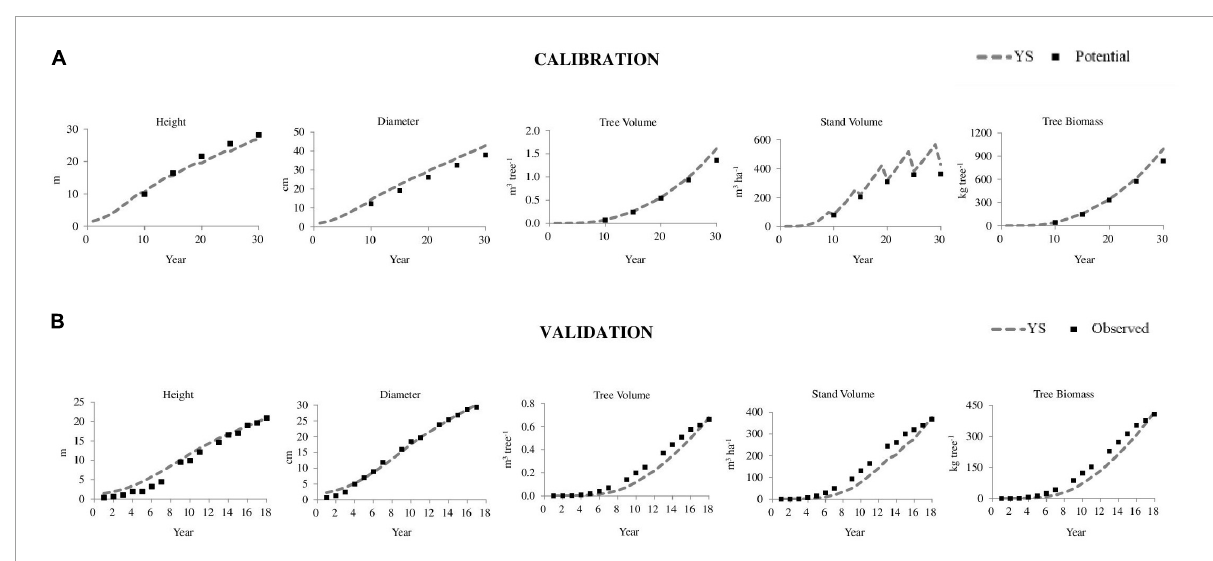
FIGURE1 Results of the calibration (A) and validation (B) of the Yield-SAFE (YS) model for Pinus radiata in Galicia (NW